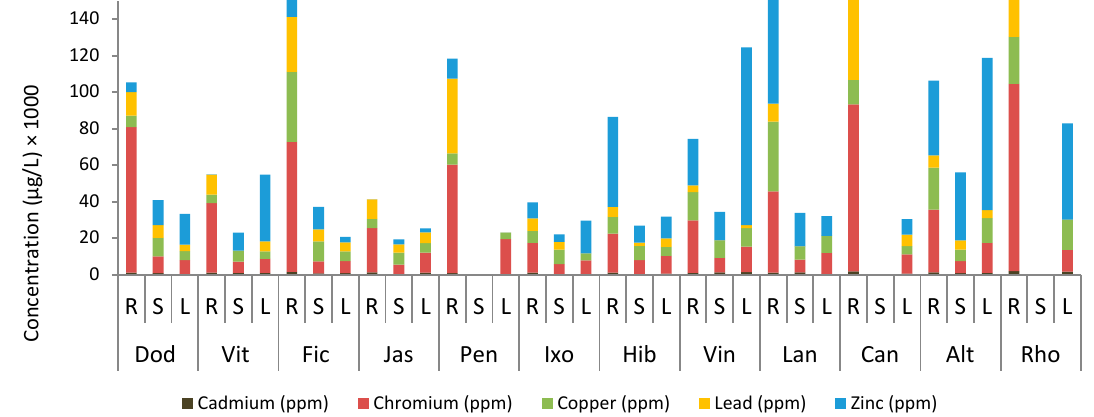
Figure 2. Average concentration of heavy metals in plant samples at the beginning of the experiment, before irrigation with synthetic greywater (R, S and L indicates roots, shoots and leaves, respectively) (please see Table S2 for the data).